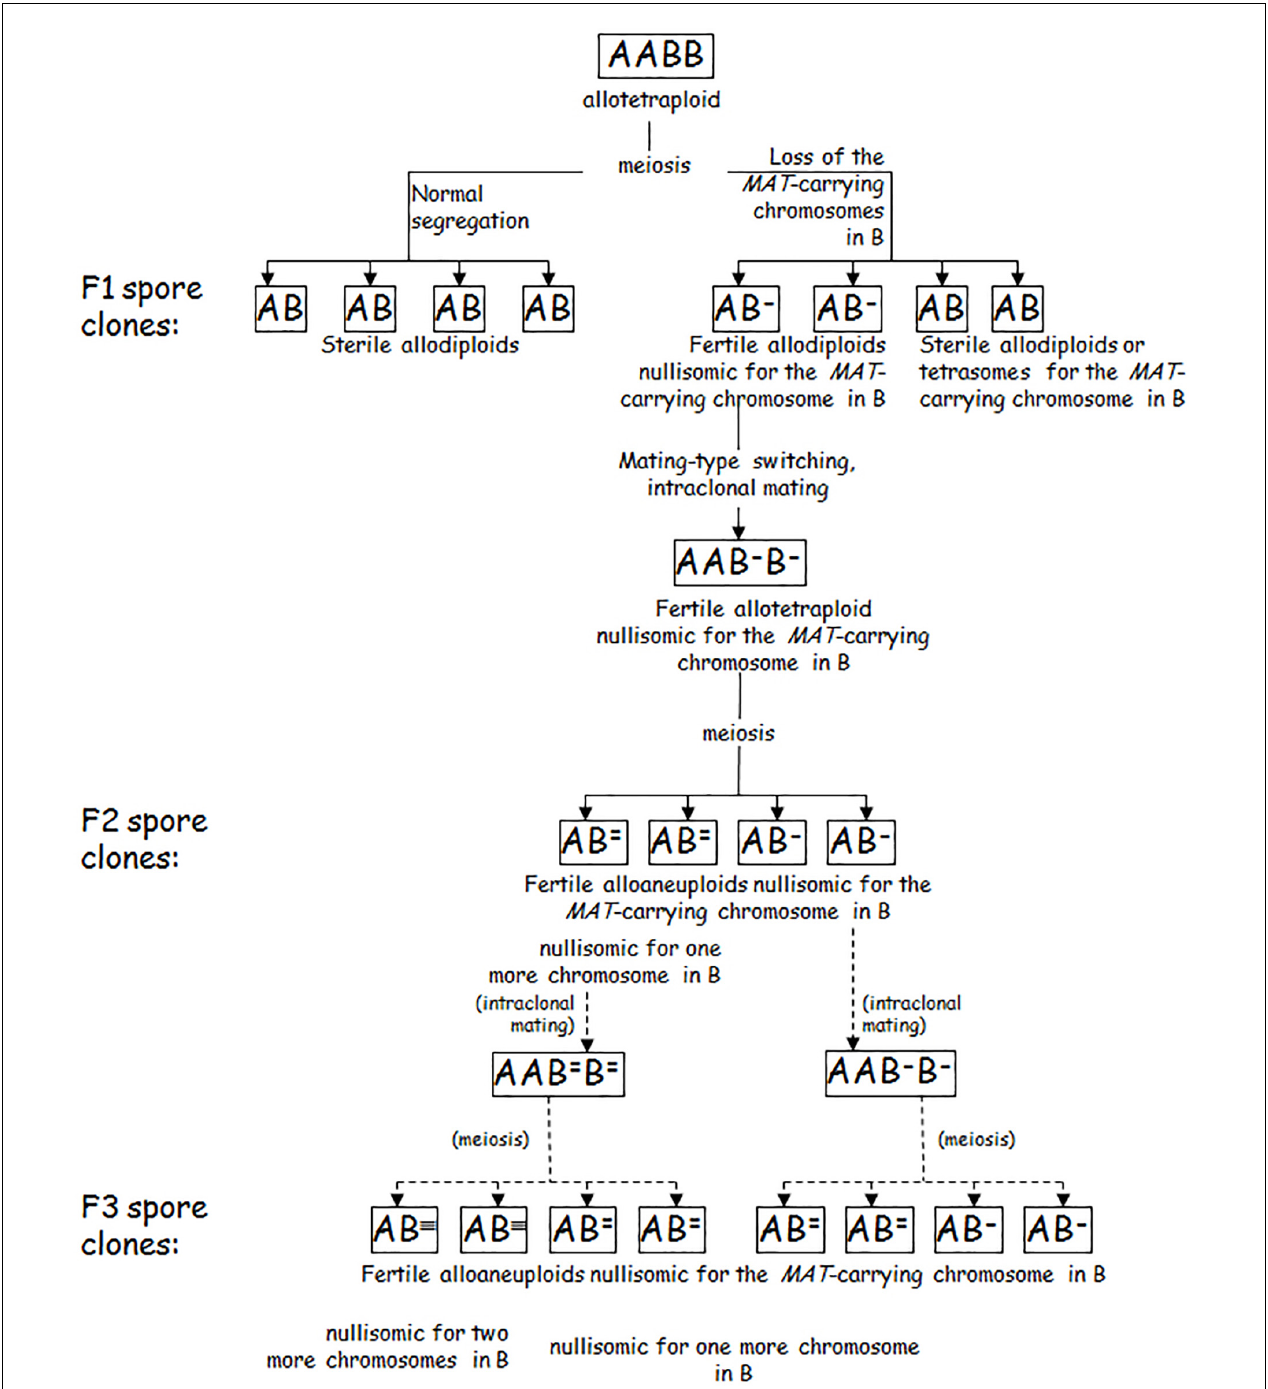
FIGURE 3 | Genome autoreduction in meiosis (GARMe). A and B: parental genomes. The superscript hyphens represent lost chromosomes. Although all hyphens are shown over B, chromosomes can be lost from either subgenome. Chimeric genomes are produced when chromosomes are lost from both subgenomes, and allosyndetic interactions (recombination) take place between the subgenomes during meiosis.